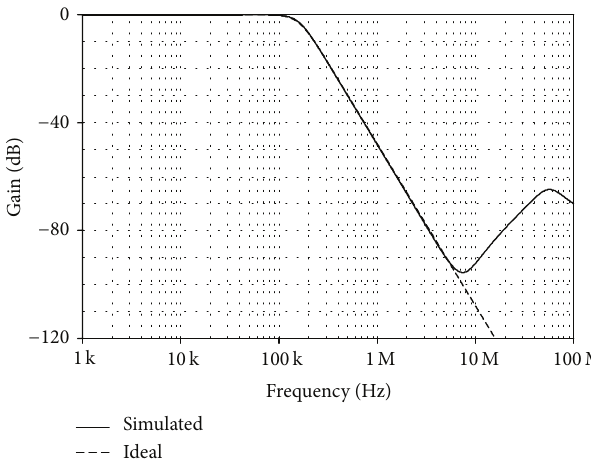
Figure 12: Simulated and ideal third-order all-pole lowpass Butter- worth current responses of Figure